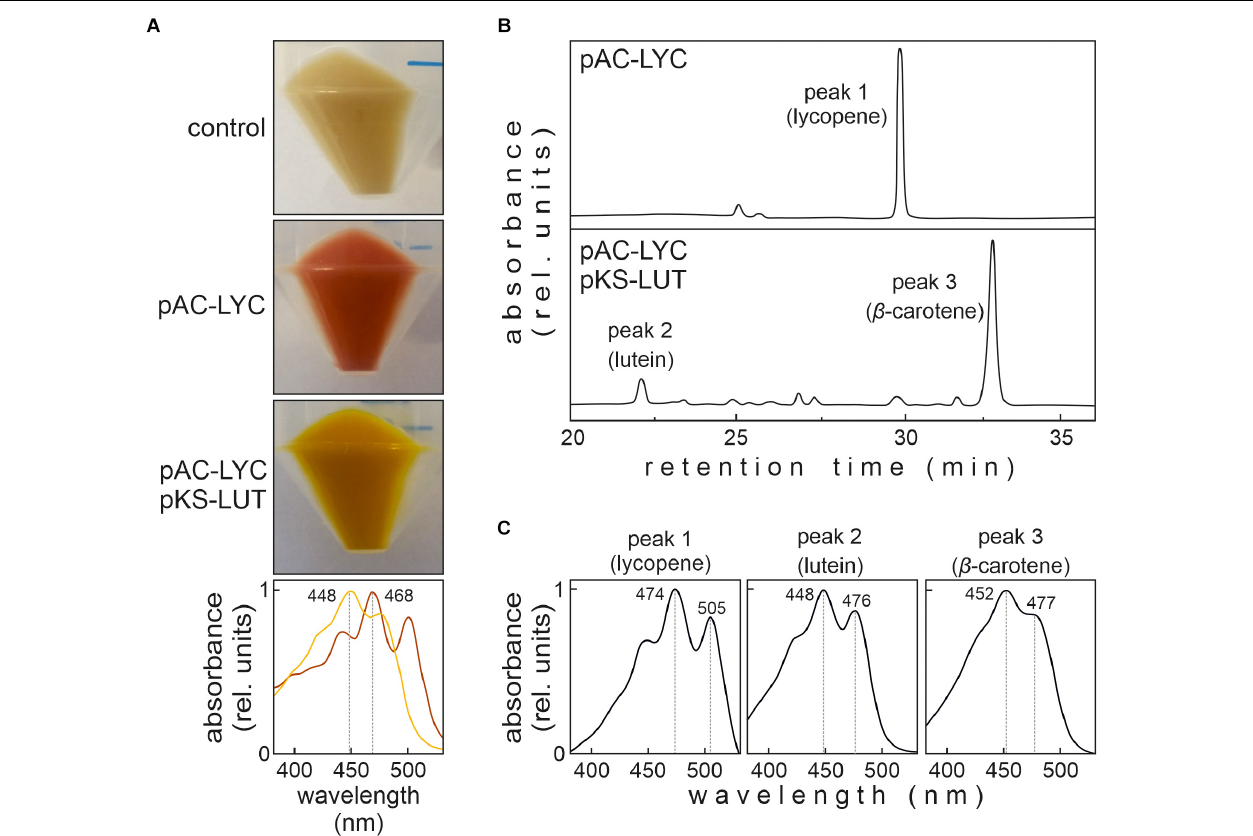
FIGURE 2 | Color complementation assay in Escherichia coli. (A) E. coli cells transformed with either pAC-LYC or pAC-LYC/pKS-LUT. Bottom panel: Absorption spectrum of total pigments extracted from pAC-LYC (red line) or pAC-LYC/pKS-LUT (orange line). Absorption maxima are indicated. (B) HPLC analyses of extracts of E. coli cells transformed with pAC-LYC or pAC-LYC/pKS-LUT. (C) Reference spectra for lycopene, lutein and β -carotene. pAC-LYC, plasmid containing the genes for lycopene production. pKS-LUT, plasmid containing the genes to generate lutein from lycopene.